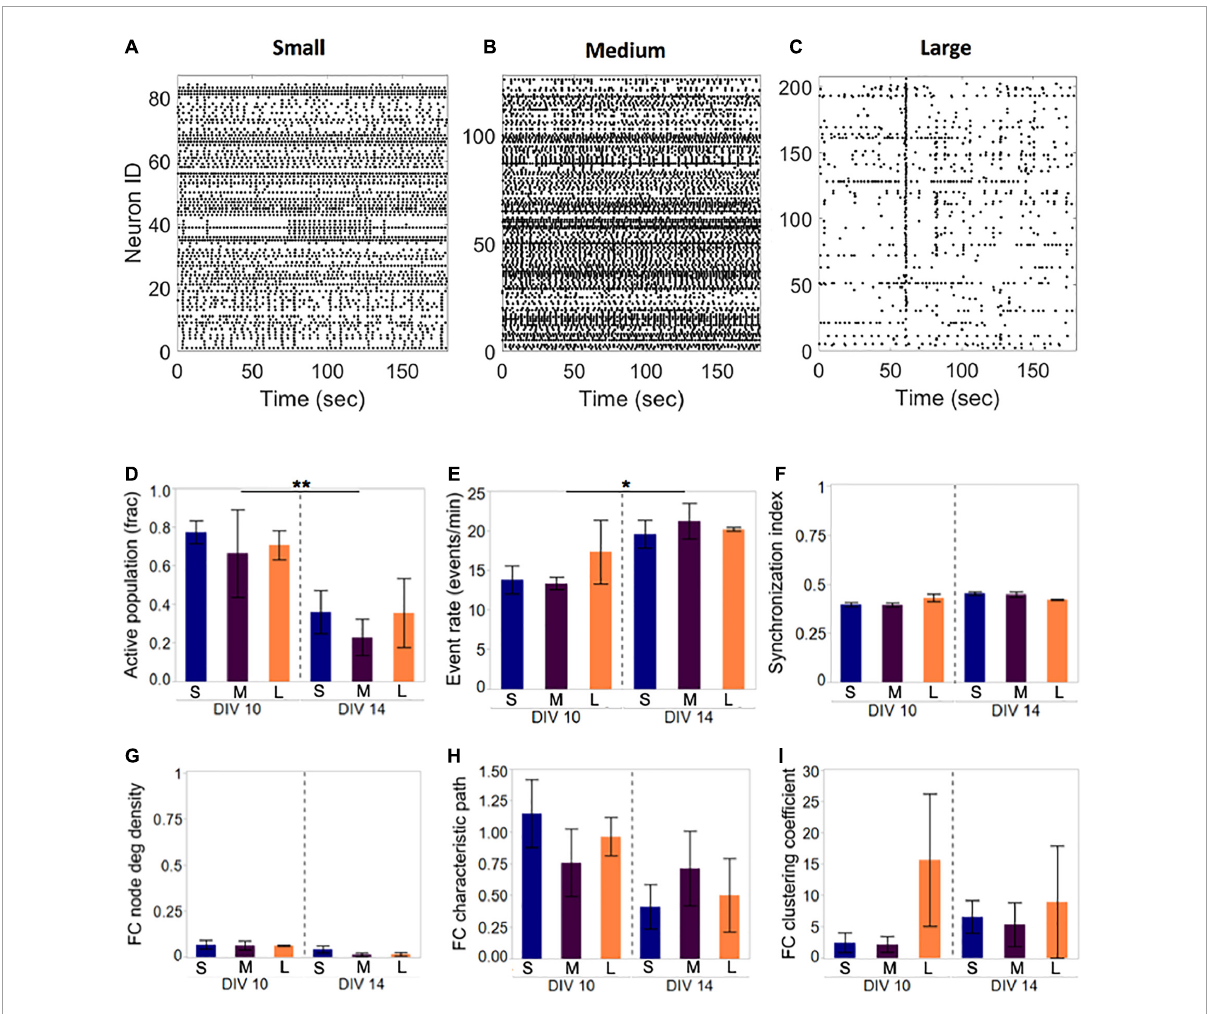
FIGURE3 Activity and network development in neuronal islands of different sizes. (A–C) Representative examples of activity patterns in neuronal islands of varying size. Activity raster plots of islands ranging in surface area between 1.1 mm 2 (small, panel A ) to 1.5 mm 2 (medium, panel B ) to 2.2 mm 2 (large, panel C ). At 10 DIV, none of the activity or network metrics computed were significantly different between the three island size categories. Low synchronization index values ( < 0.5) and functional connectivity node density ( < 0.1) indicate sparsely correlated activity and connected networks. ( D–I ) By 14 DIV, the fraction of the neuronal population participating in spontaneous activity decreased uniformly in all island sizes, but activity rate increased significantly in the remaining active neurons ( D,E ). Developmental age did not significantly alter the synchronization level ( F ), nor the functional network structure as assessed by the three network metrics ( F,G ). Error bars indicate SEM. Significance level: * p < 0.05; ** p <